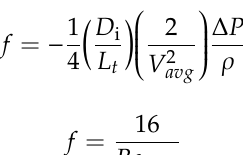
Figure 3. Grids system: ( a ) tube section, and ( b ) diffuser section.